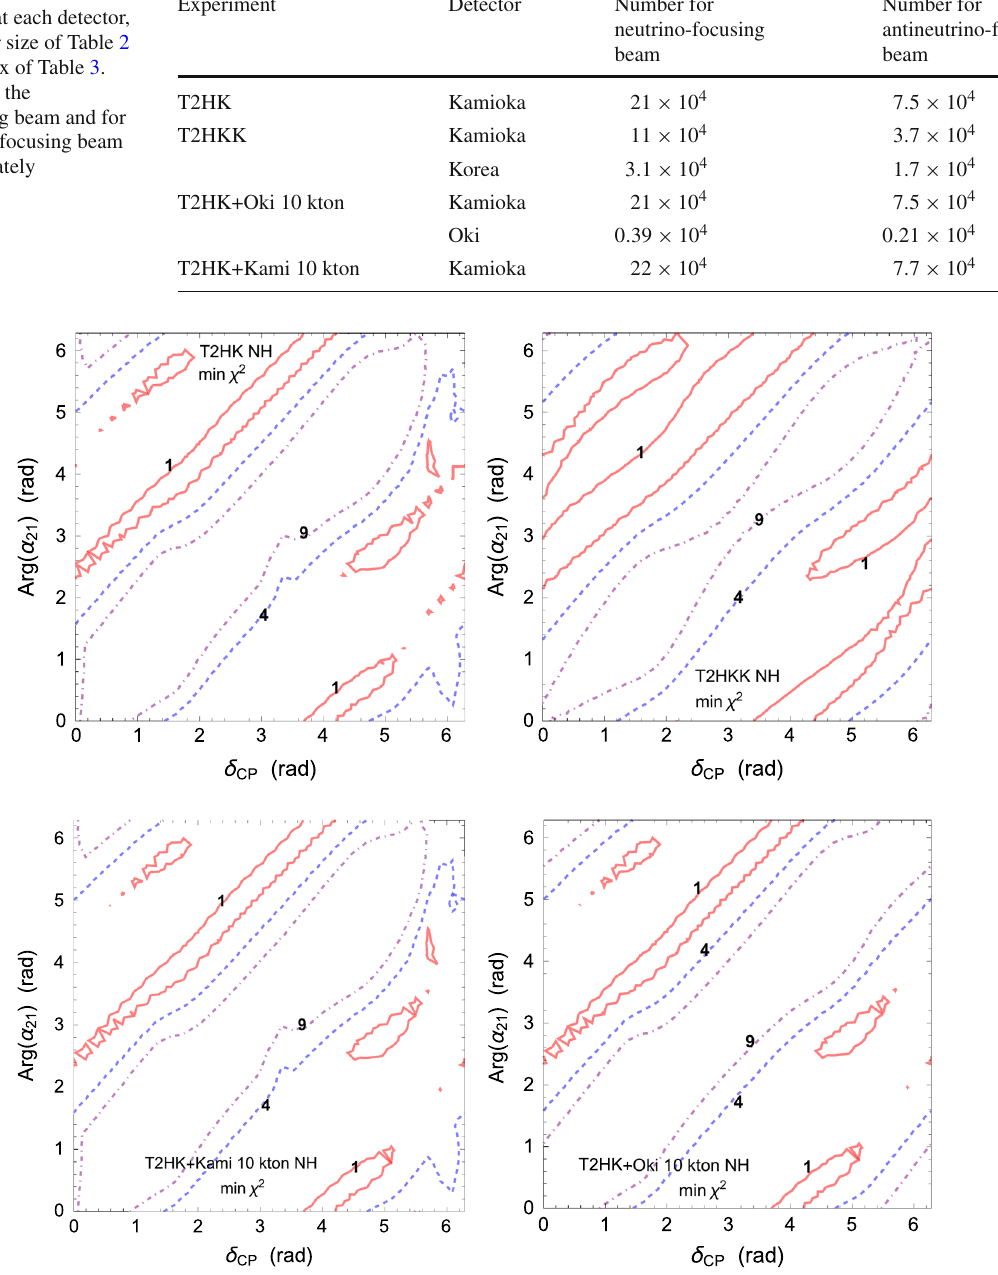
Fig. 1 The minimum of χ 2 ((cid:20)) Eq. (32), min χ 2 , on the plane of the standard CP -violating phase δ CP and the new phase in the non-unitary mixing matrix Arg( α 21 ). The benchmark with Eq. (26) is assumed, and the true mass hierarchy is normal. The upper-left, upper-right and lower-right subplots correspond to the T2HK, the T2HKK, and the plan